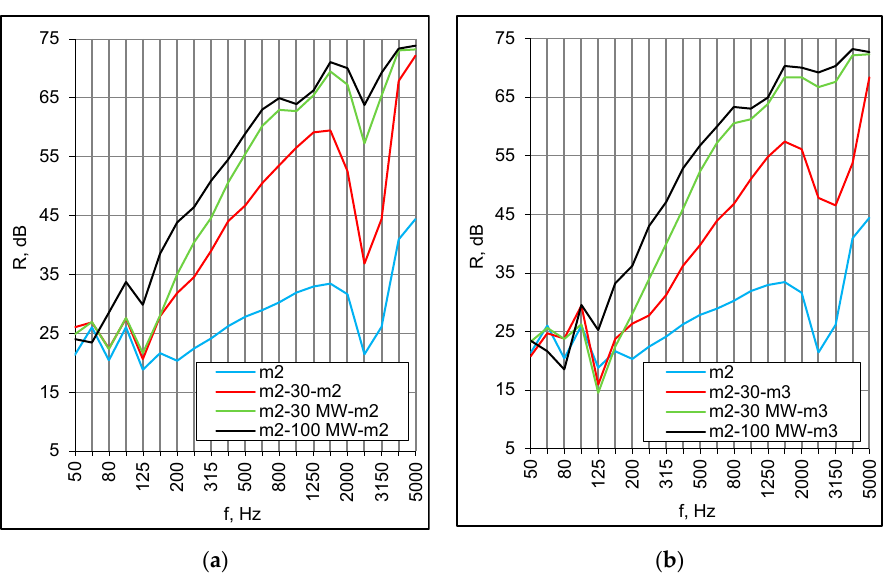
Figure 5. ( a ) Sound reduction index of m2 panels in different configurations, small samples; ( b ) Sound insulation of m2/m3 panels in different configurations, small samples.